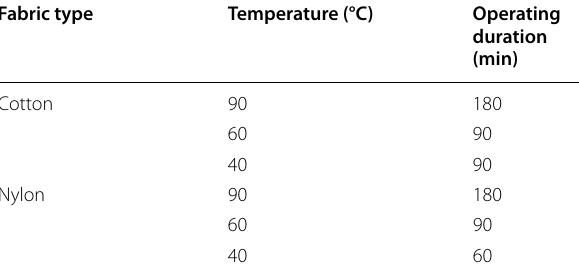
Table 2 Washing specifications for cotton and nylon fabrics Fabric type